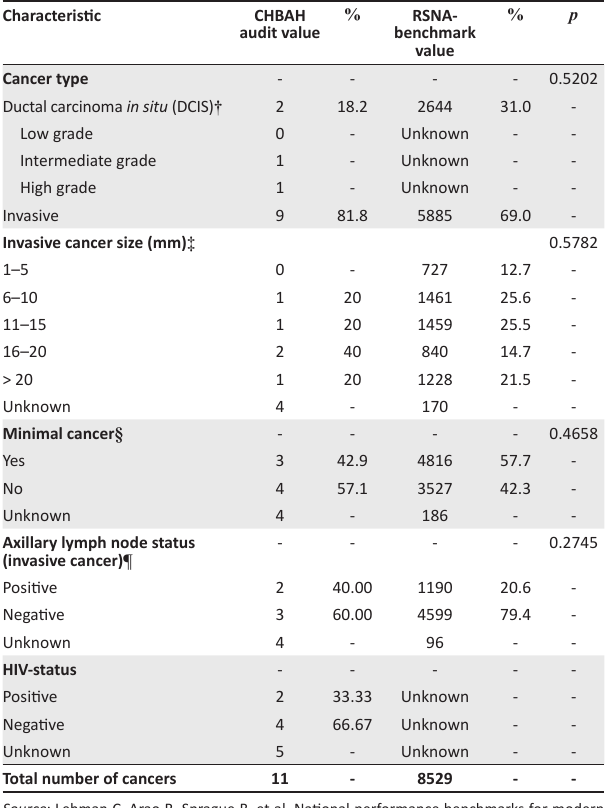
TABLE 5: Derived cancer characteristics for screening mammography ( n =